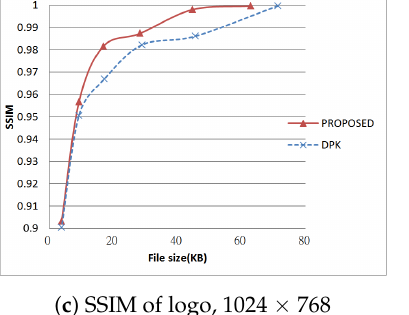
Figure 30. SSIM of test results, Part